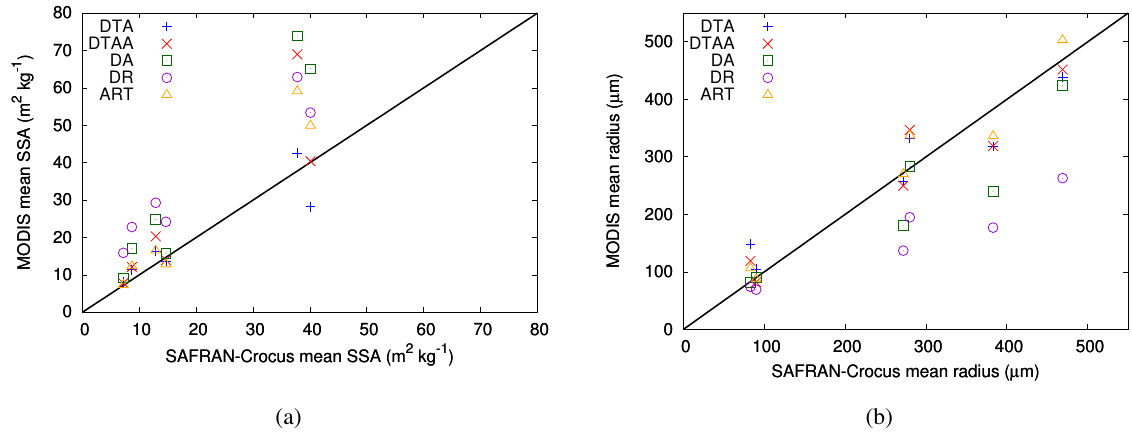
Fig. 7. Mean SSA (a) and optical radius (b) obtained from satellite retrievals versus SAFRAN-Crocus mean value, over the six studied dates. DTA in blue, DTAA in red, DA in green, DR in purple and ART in orange.